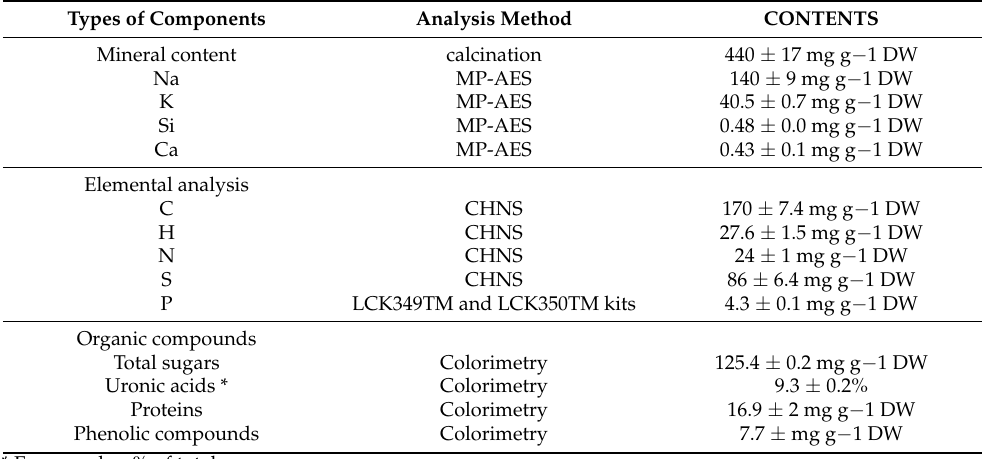
Table 3. Chemical composition of SL35 (average ± standard deviation, n = 3). CHNS: elemental analysis; DW: Dry Weight; MP-AES: Microwave Plasma Atomic Emission Spectroscopy.